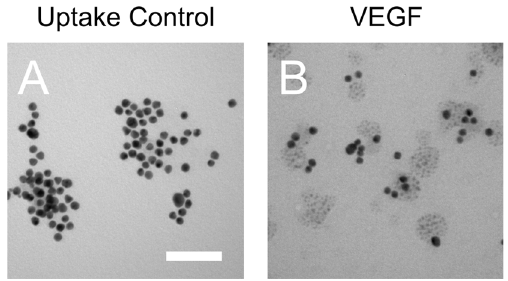
Figure 1. Physical Characterisation of SmartFlare RNA detection probes : SmartFlares were re-suspended in nuclease-free deio- nised water and 10 μ L dried onto formvar/carbon electron microscopy grids. Samples of the Uptake Control (A) and VEGF SmartFlares (B) were imaged on a Tecnai spirit Transmision Electron Microscope (TEM) at a nominal magni fi cation of 150,000 times. The scale bar represents 100